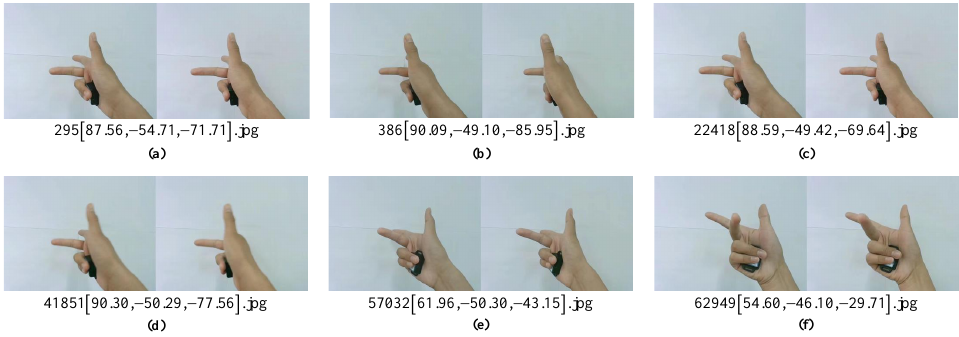
Figure 8. A partial sample of C-Posehand dataset. ( a – f ) are six samples in the